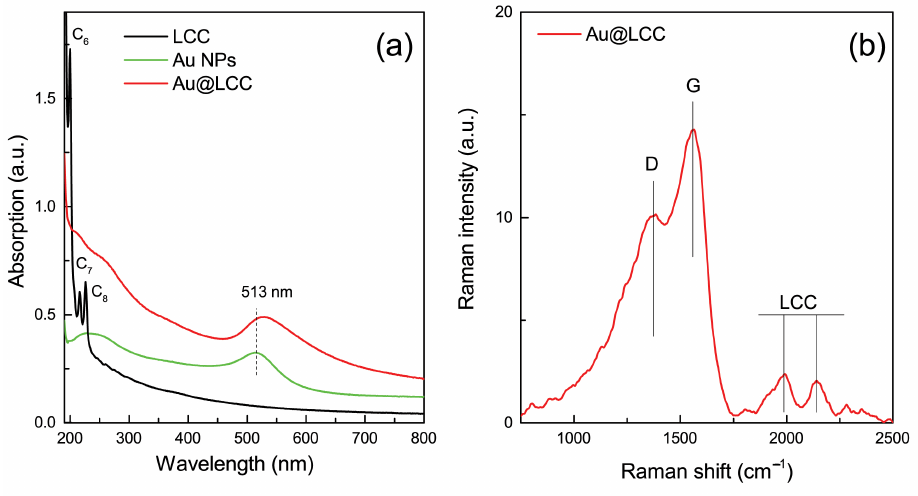
Figure 3. ( a ) UV-Vis absorbance spectra of LCC (black line), Au NPs (green line) and Au@LCC (1.1 ratio) (red line); ( b ) Raman spectra of